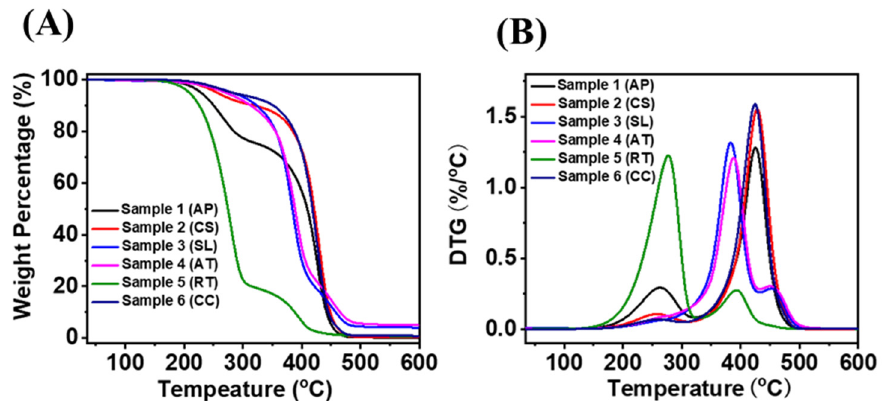
Figure 6. TGA ( A ) and DTG ( B ) results of microbial oils A. protothecoides (AP) and C. sorokiniana (CS); thraustochytrids S. limacinum (SL) and Aurantiochytrium sp. T66 (AT); and yeasts R. toruloides (RT) and C. curvatus (CC) under air atmosphere.